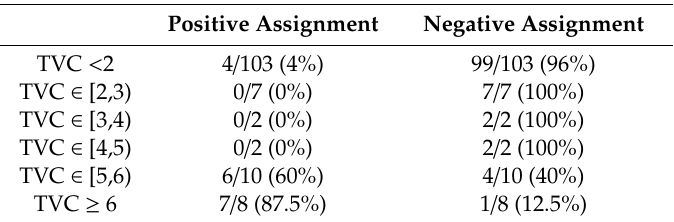
Table 2. Classification results for test samples in the whole range of TVC counts obtained during the microbiological analyses of vanilla cream samples.